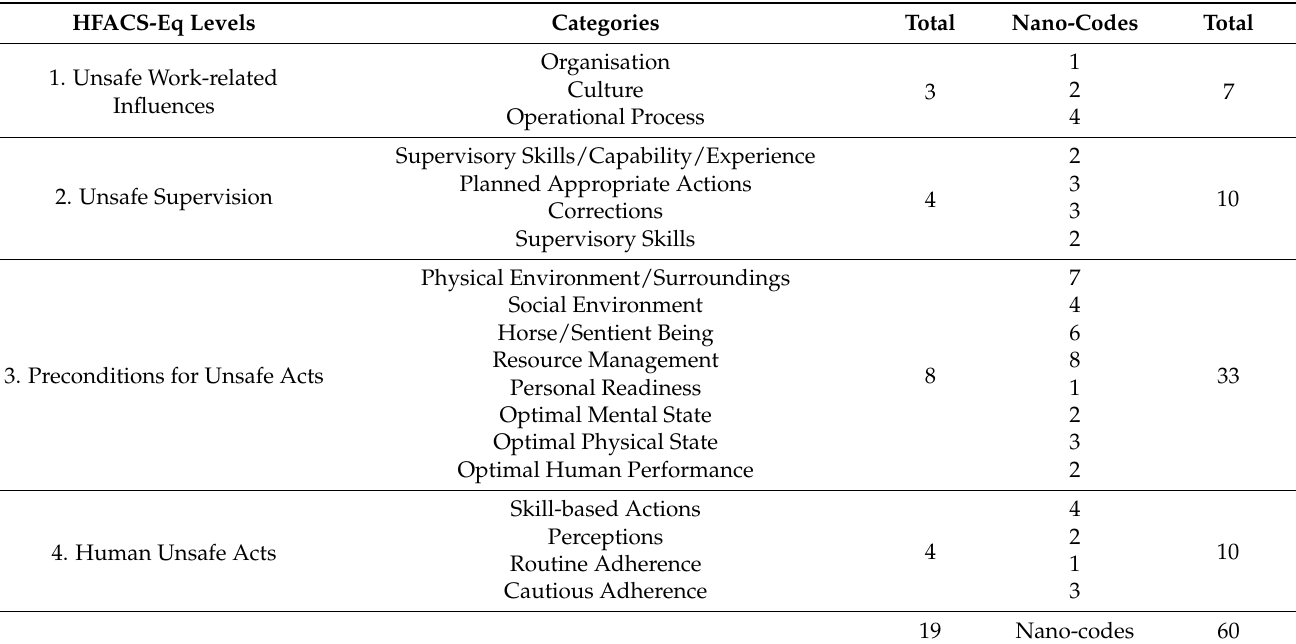
Table 1. HFACS-Eq summary of final data set levels, categories, and